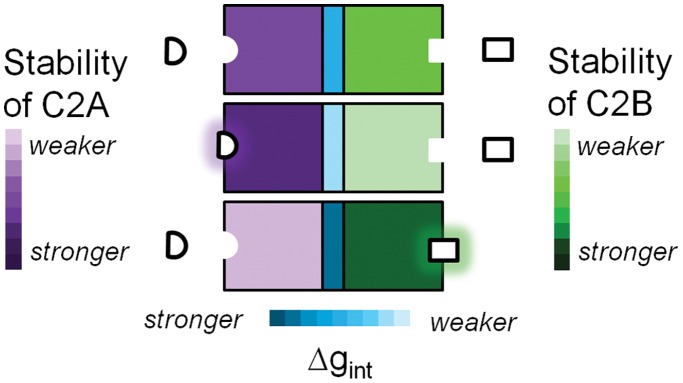
Conceptual representation of negative coupling.In the absence of bound ligand (top), domains have basal level stability. When a ligand specific to the C2A domain binds (middle), C2A is stabilized and C2B is destabilized through negative coupling. When a ligand specific to C2B binds (bottom), the opposite effect is seen; C2B is stabilized and C2A is destabilized. Note that binding of domain-specific ligands lowers the probability of binding-competent conformers being occupied in the adjacent domain through domain destabilization, representing a form of allosteric regulation. The extent of negative coupling, like domain stability, changes depending on the types of ligand present.